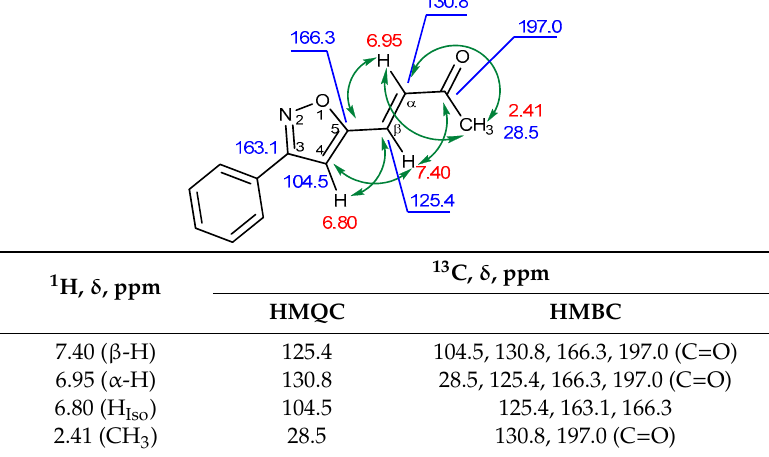
Table 1. Cross-peaks in heteronuclear single-quantum correlation and heteronuclear multiple-bond correlation spectra of compound (E)- 4c .